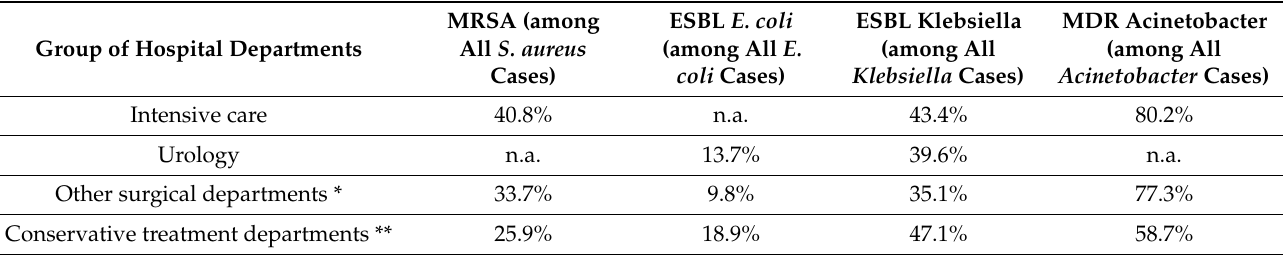
Table 4. The percentage of multidrug resistant bacteria diagnosed in different hospital departments. Minimal number of 30 isolates per each strain and each department, otherwise not